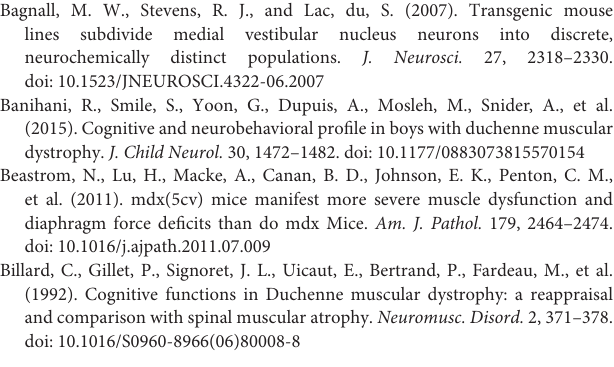
Supplementary Figure 1 | (A) DIC image (left) and fluorescence image (using illumination from a 473nm LED and a GFP filter set, right) of CbN neurons showing strong YFP expression in a subset of CbN neurons in the Thy1-YFP16 mouse line. ∗ YFP- (non-glutamatergic) neurons, ∗∗ YFP + (glutamatergic) neuron. (B) Graph showing mean mRNA expression (normalized to actin) of VGlut2 (glutamatergic neuron marker) in PCs (dark gray bar, n = 12 cells from 2 animals) and YFP + CbN neurons (light gray bars, n = 14 cells from 2 animals) using single cell patch qRT-PCR. Error bars indicate SEM. ∗ p ≤